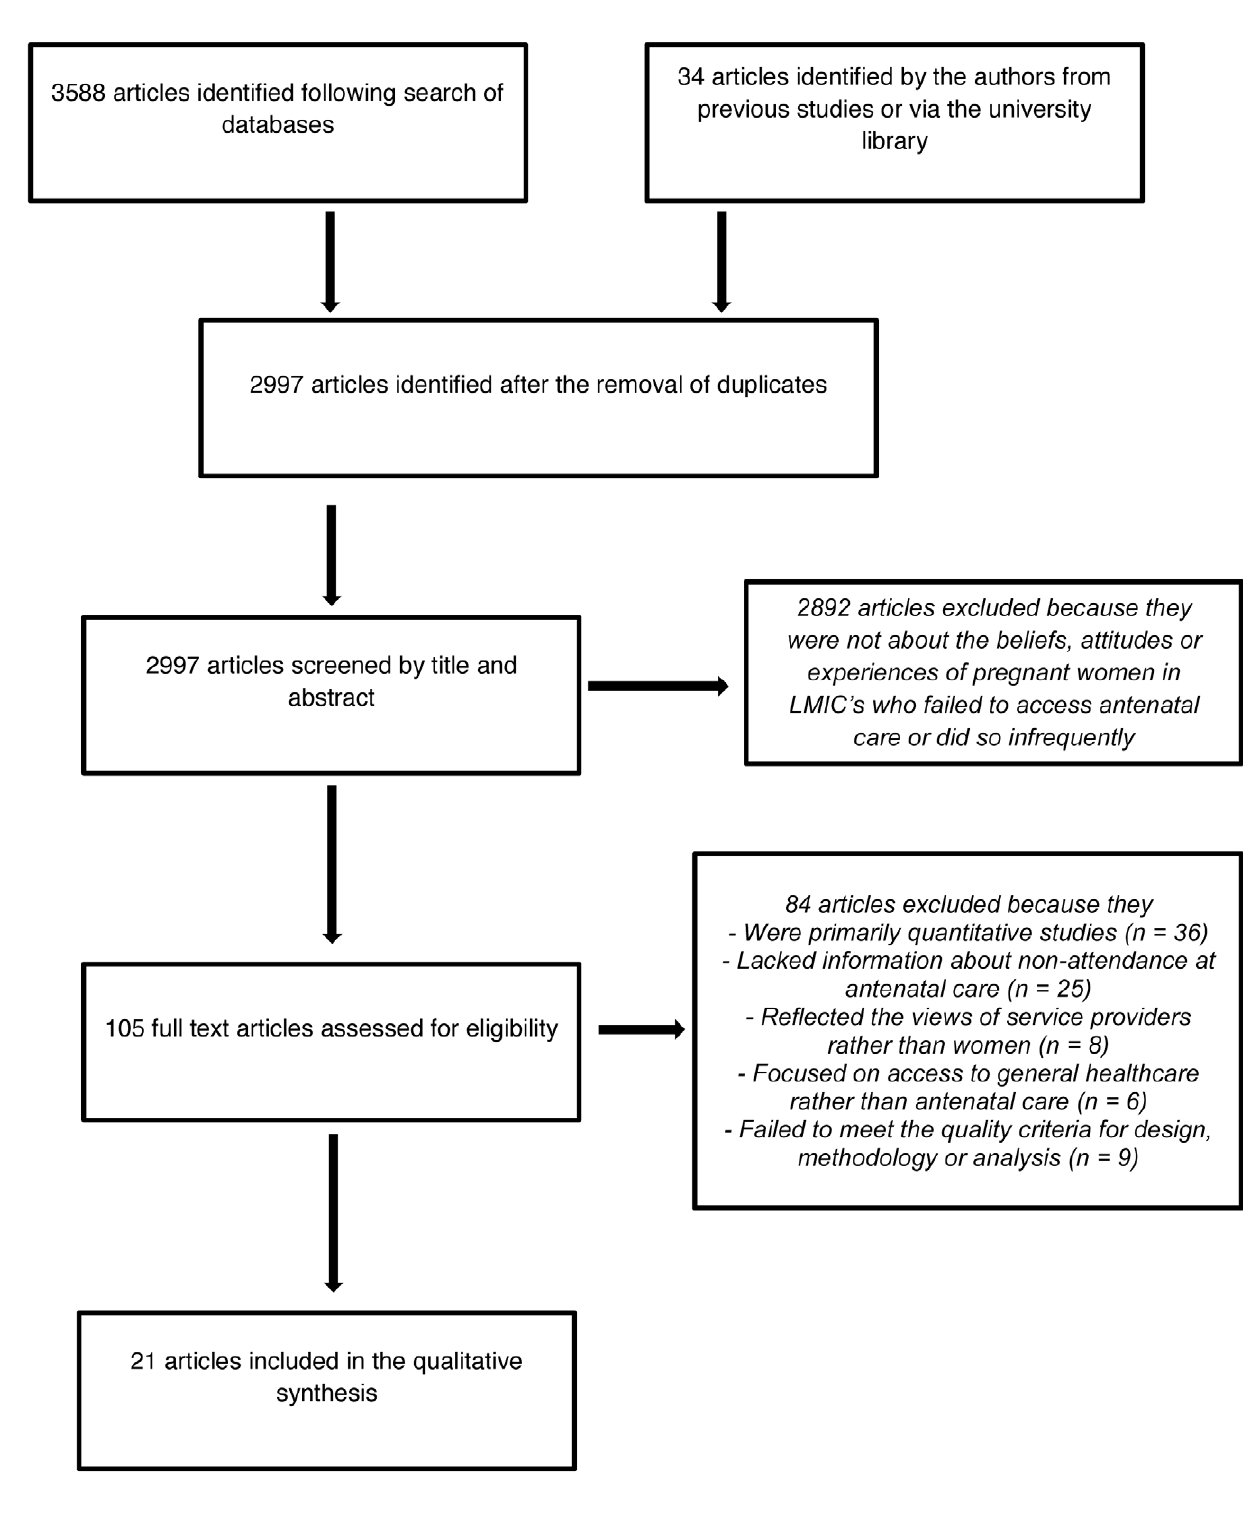
Figure 1. Flow chart summarising search strategy.